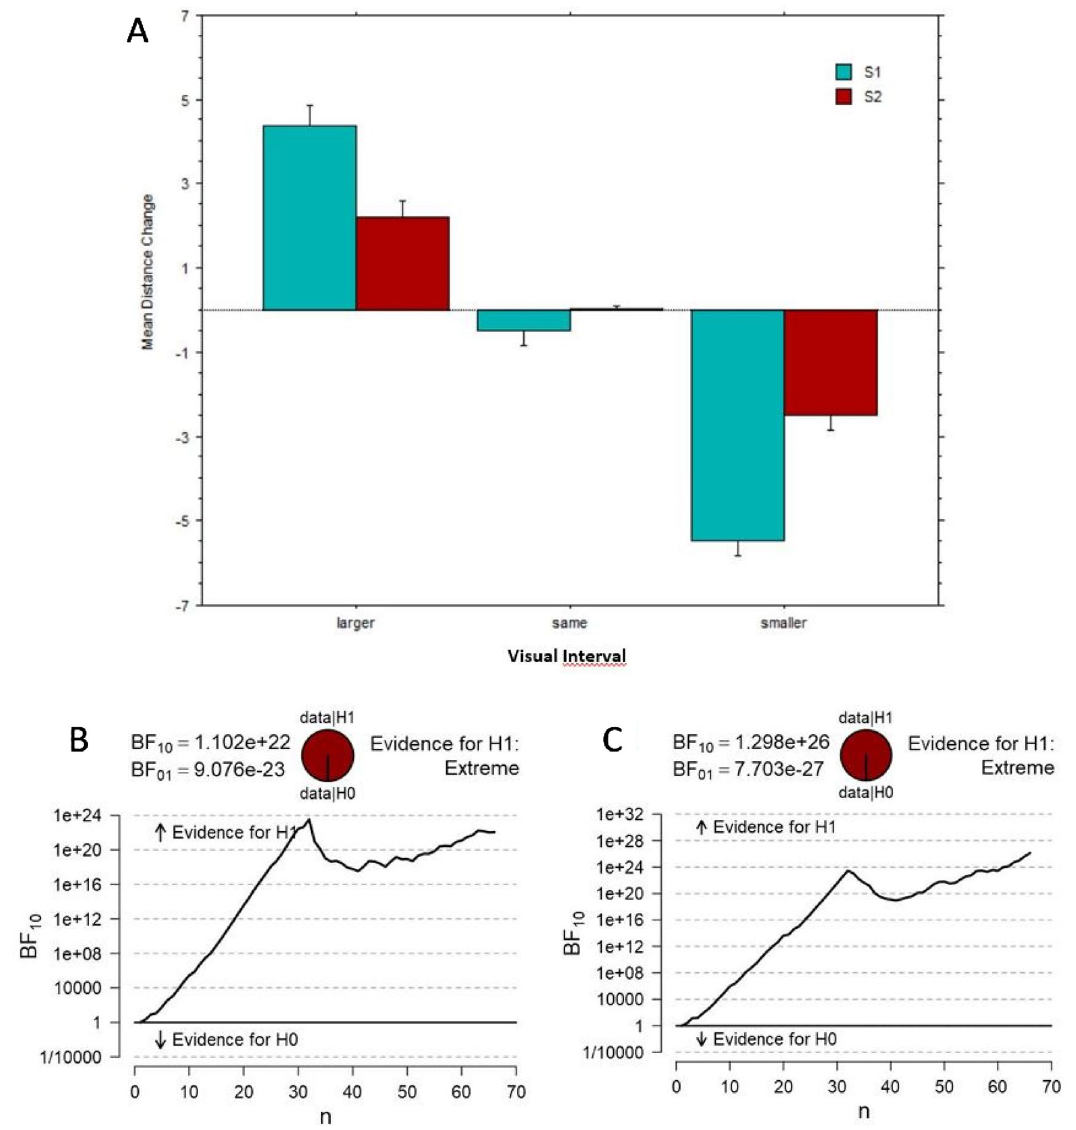
Figure 1. Experiment 1. ( A ) Bar graph of Mean Distance Change for visually larger, same, smaller intervals than the heard interval (split by Singers 1 and 2). Error bars are 95% confidence intervals. ( B , C ) Bayesian t-test sequential analyses of Larger Seen Interval versus Same intervals and Smaller Seen Interval versus Same Seen Interval,